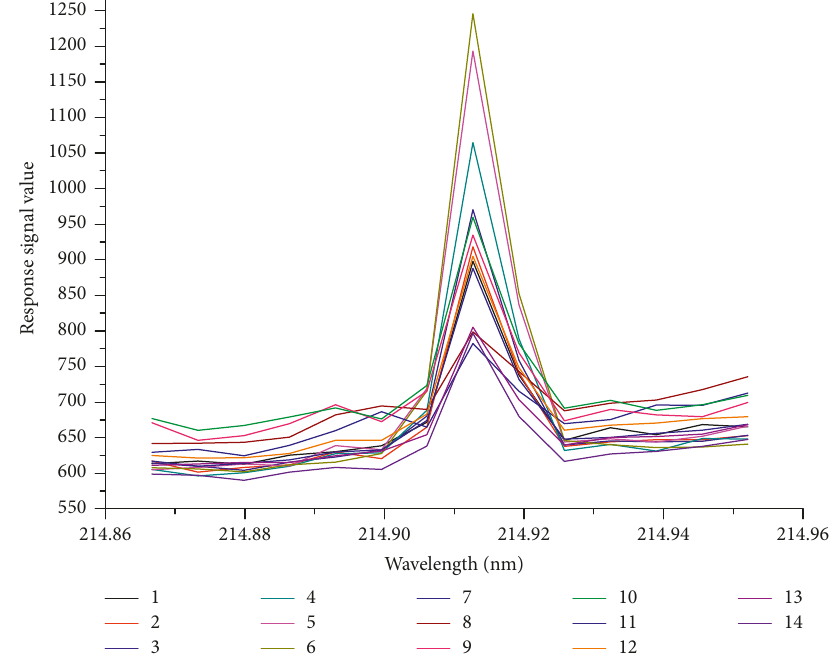
Figure 3: The ICP-OES spectrogram of phosphorus with standard solutions diluted by soil digestion solution of